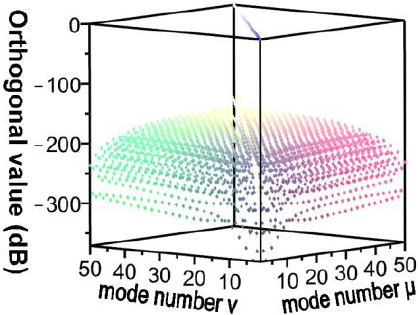
Figure 14. Plot of the power propagation in the x - z plane for the total counterpropagating HE . 11